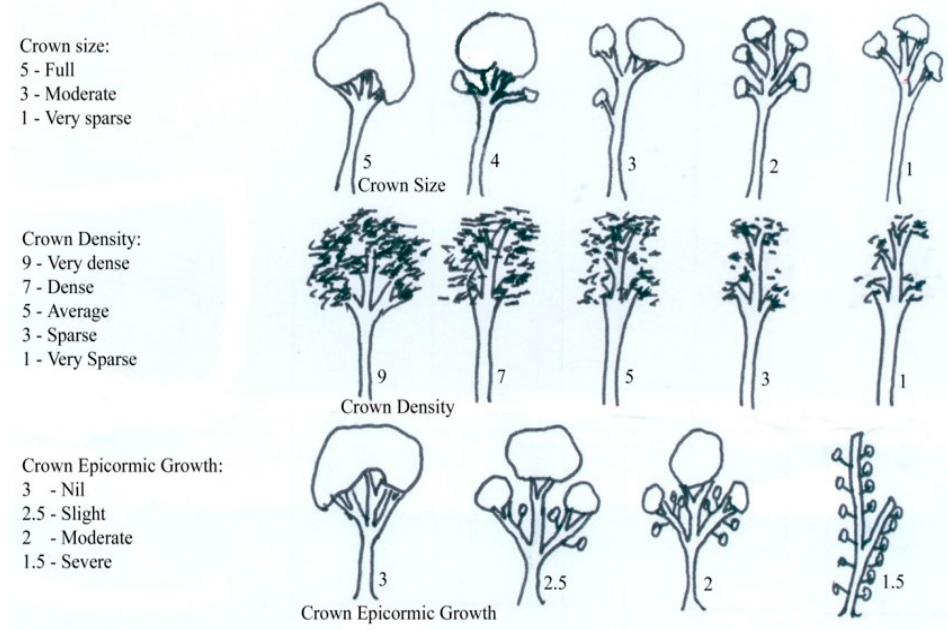
Figure 1. Diagrammatic representation of the assessment of urban visual vitality index for mature trees (after [4,7,8,12]).